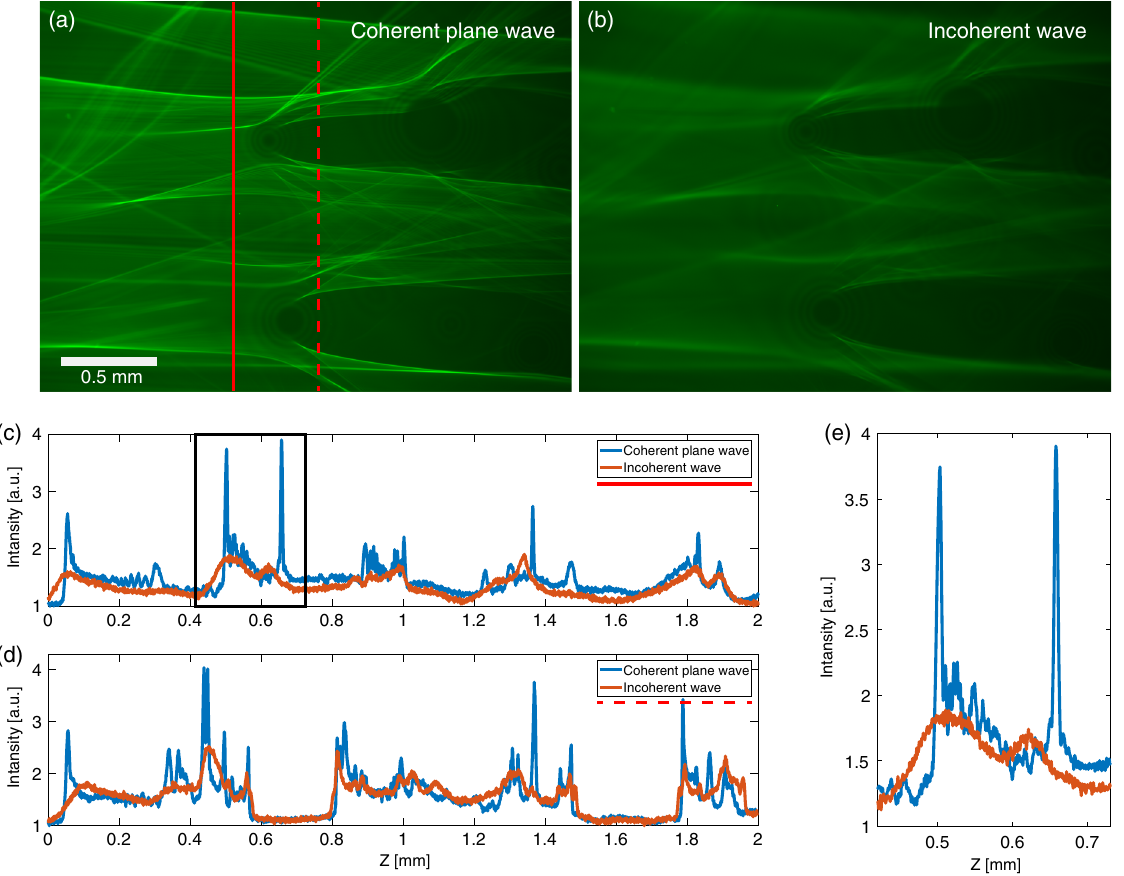
FIG. 3. (a),(b) BF intensity patterns observed in the same region of the soap film for a coherent plane wave (a) and an incoherent wave (b). The two images demonstrate the smearing effect of incoherence smoothening the intensity pattern and concealing the coherent features. (c),(d) Intensity cross section taken along the full (c) and dashed (d) red lines in (a) and (b) (blue and red plots, respectively). The cross sections highlight the stark contrast between the two BF patterns. (e) Enlargement of the region marked in (c), highlighting the difference in the region surrounding each BF